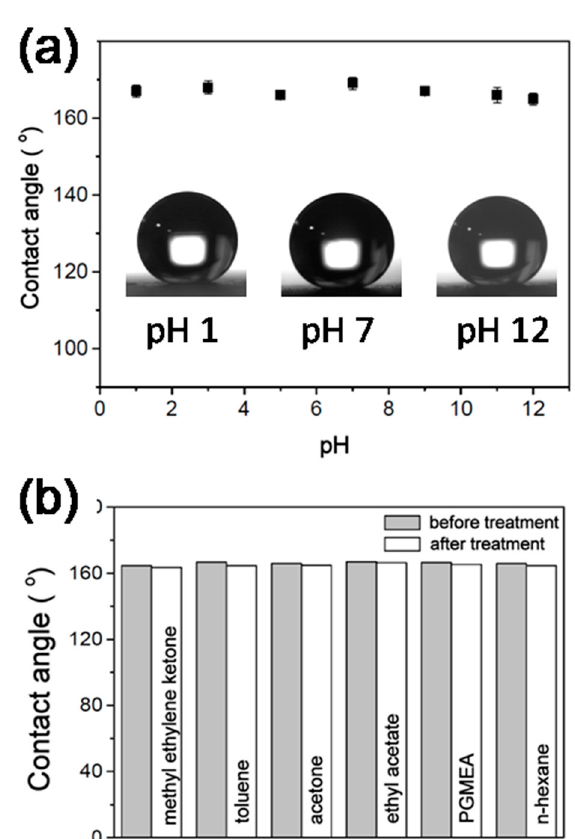
Figure 6. ( a ) Relationship between pH and water contact angle on the superhydrophobic CNT / polybenzoxazine film. ( b ) Durability of the superhydrophobic films after treatment with organic solvents.